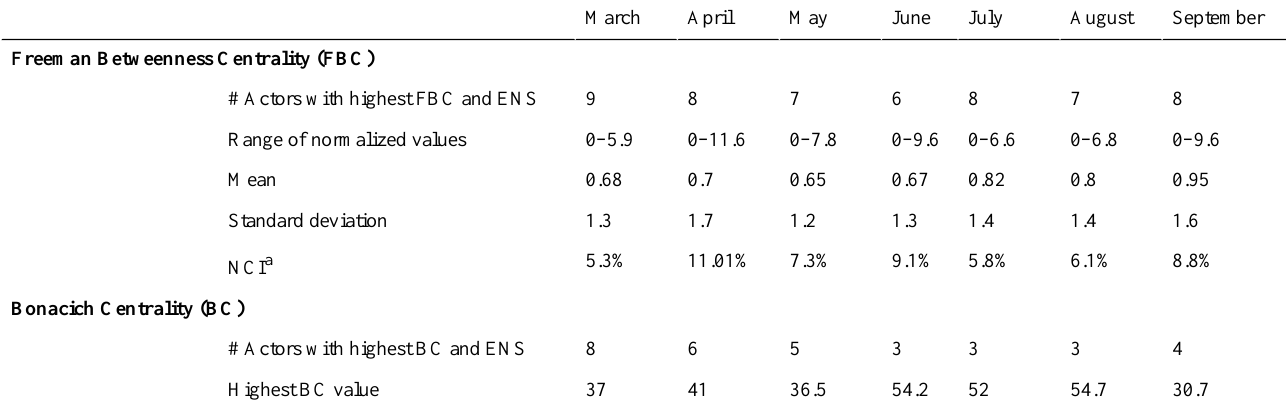
Table 2. Summary of Bonacich and Freeman centrality measures of the Airtel mobile phone closed user group by month from March 2011 to September 2011 (source: Airtel closed user group call